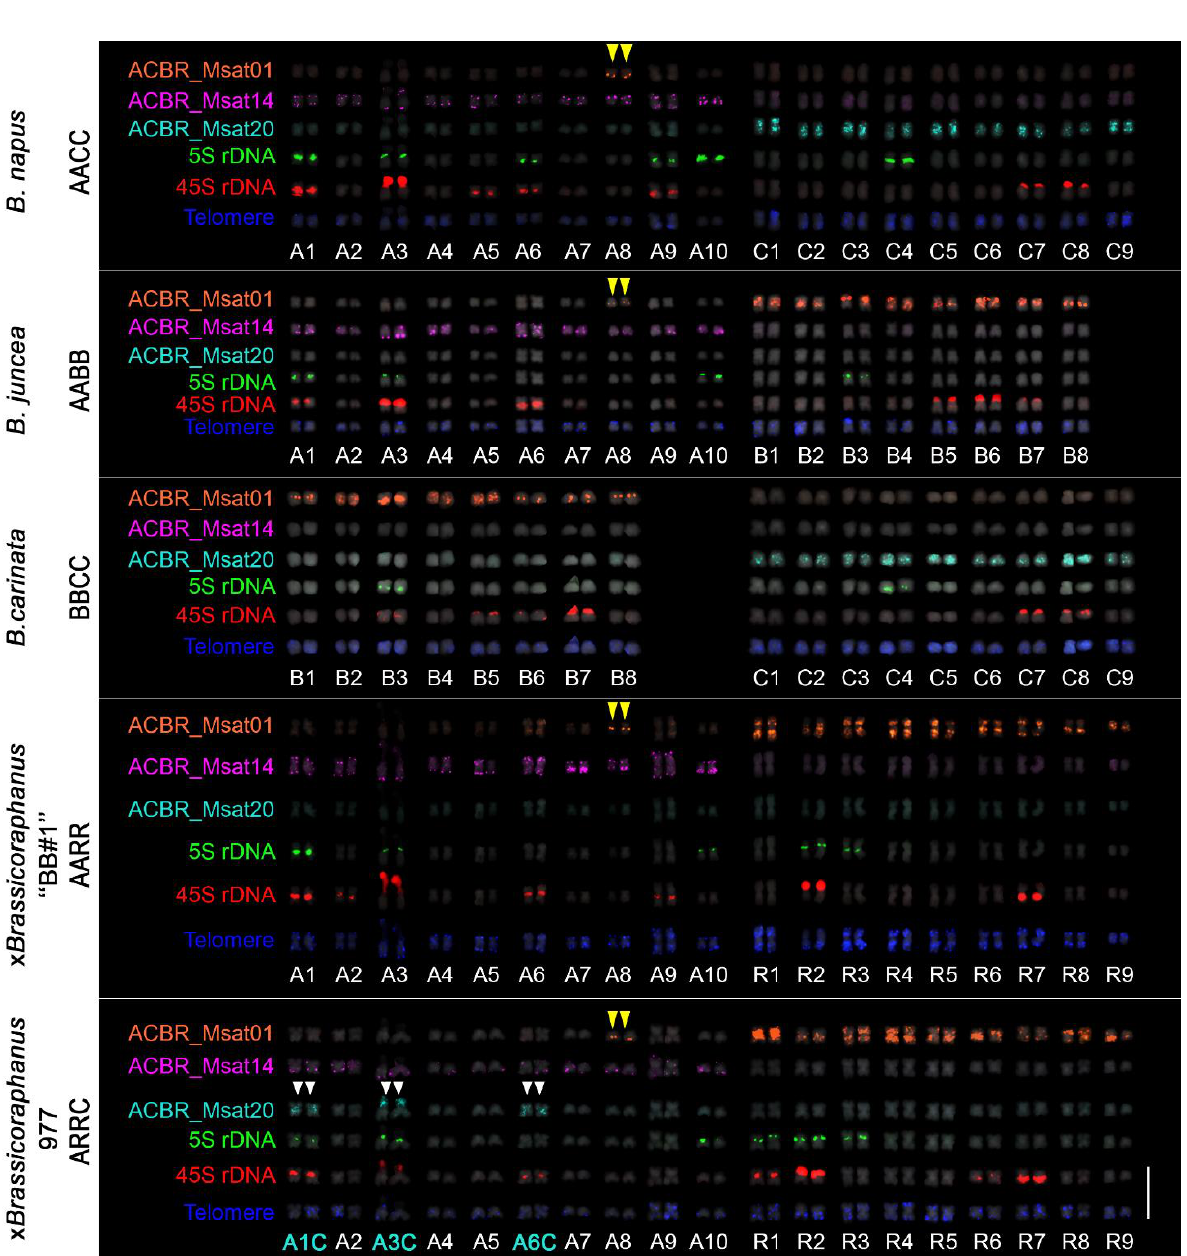
Figure 5. Karyogram of natural and synthetic Brassica and Raphanus allotetraploids. The chromosomal distribution of ACBR_msat01, ACBR_msat14, ACBR_msat20, 5S rDNA, 45S rDNA and Arabidopsis -type telomere repeats are shown. ACBR_msat14 localized at the subterminal with some in the interstitial regions in the A-genome chromosomes (A1 – A10). ACBR_msat20 localized at the interstitial regions of C-genome chromosomes (C1 – C9). ACBR_msat01 localized at the interstitial regions of B-genome chromosomes (B1 – B8) and extra signals at the paracentric region of chromosome A8 (yellow arrowheads). A- genome chromosomes with ACBR_msat20 signals are shown in white arrowheads. Scale bar = 10 μm.